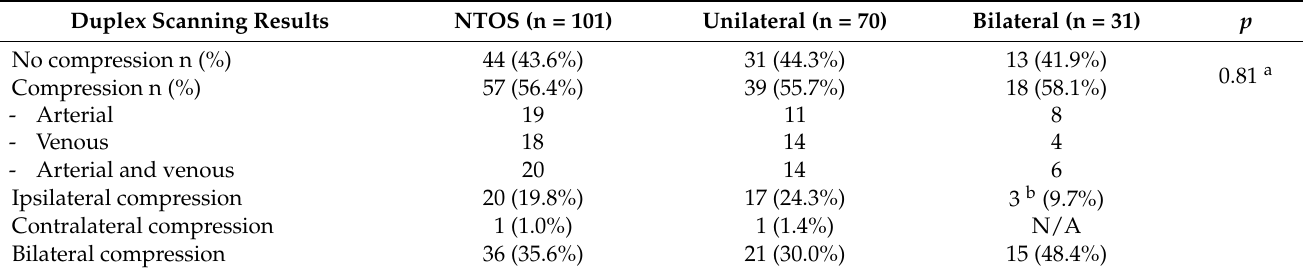
Table 3. Vessels assessment by duplex ultrasound scanning in patients with unilateral and bilateral